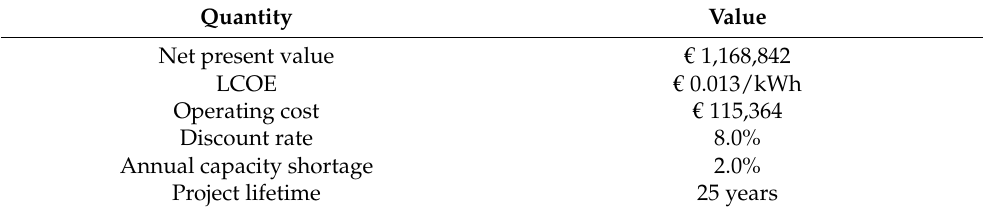
Table 9. Economic values of proposed